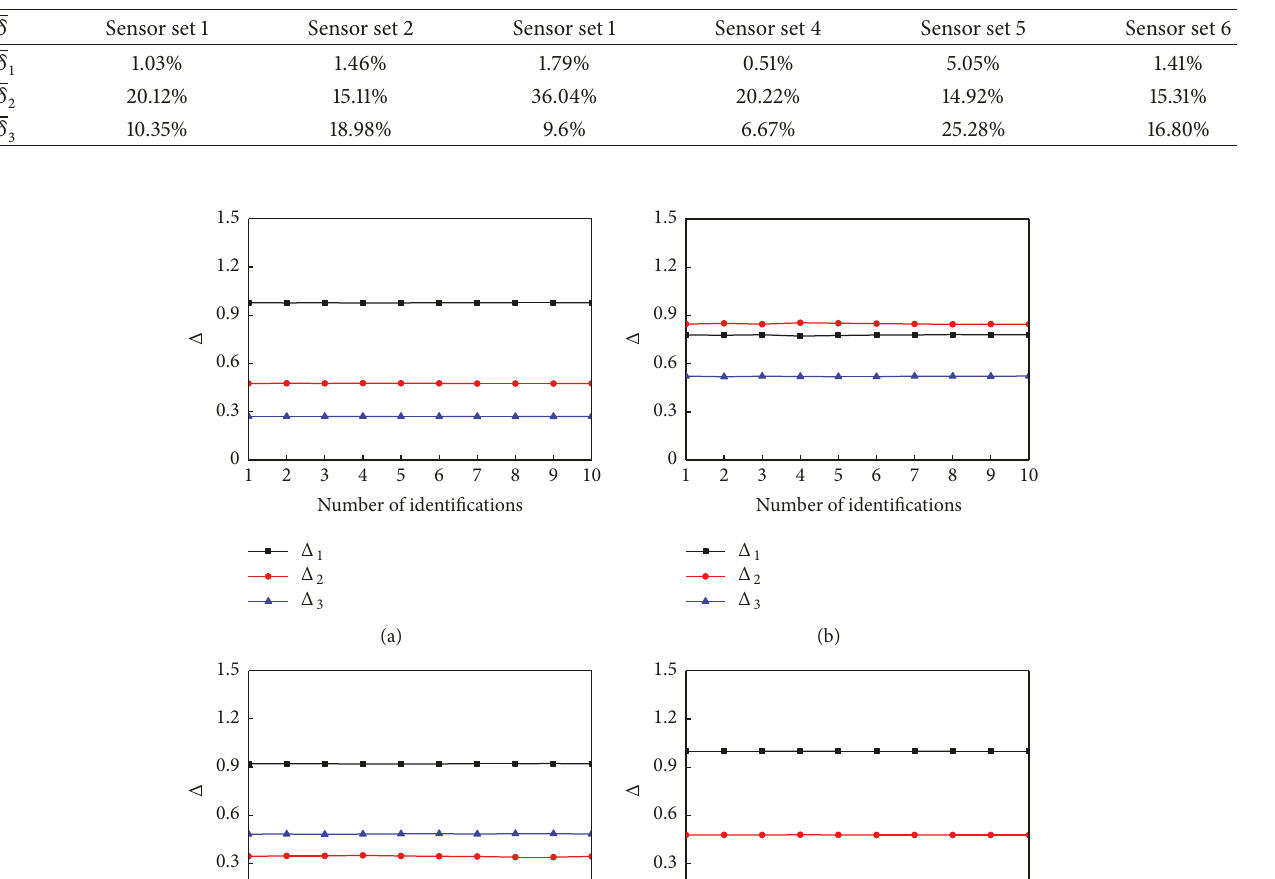
Table 4: The mean values of 𝛿 with 10% measurement noise.